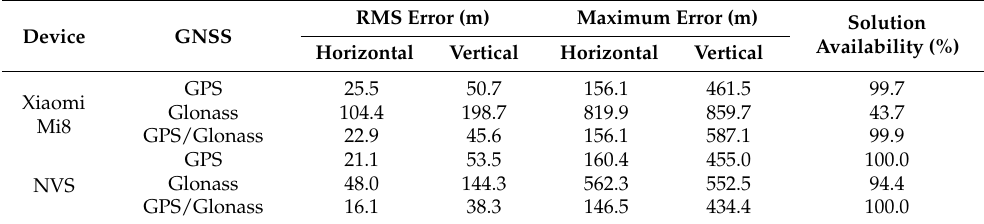
Table 5. Comparison between Xiaomi Mi8 and NVS, with RAIM application (all available